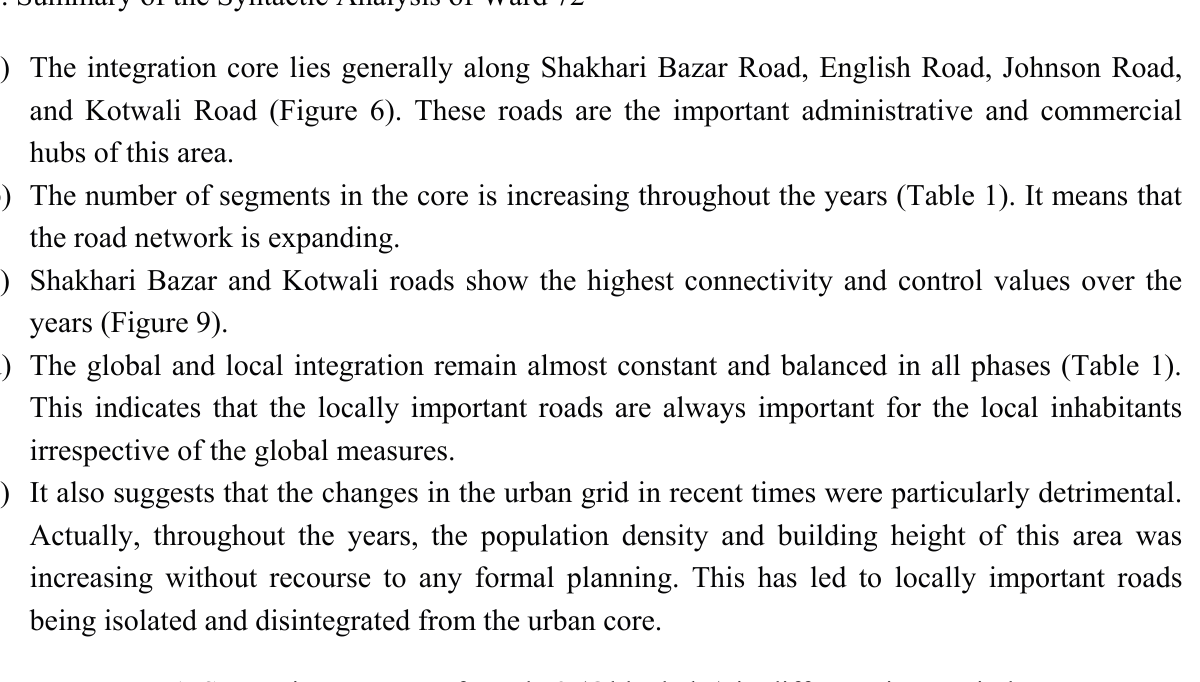
Table 1. Syntactic measures of ward 72 (Old Dhaka) in different time periods. Syntactic